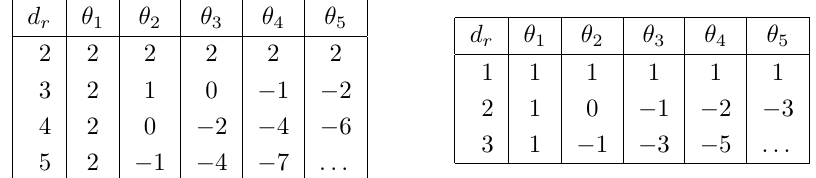
Table 1 . Scaling exponents at the Gaussian fixed point for ζ = 1 (left) and ζ = 1 / 2 (right). are coupled to the external momenta only via the regulator depending on N 2 ζ